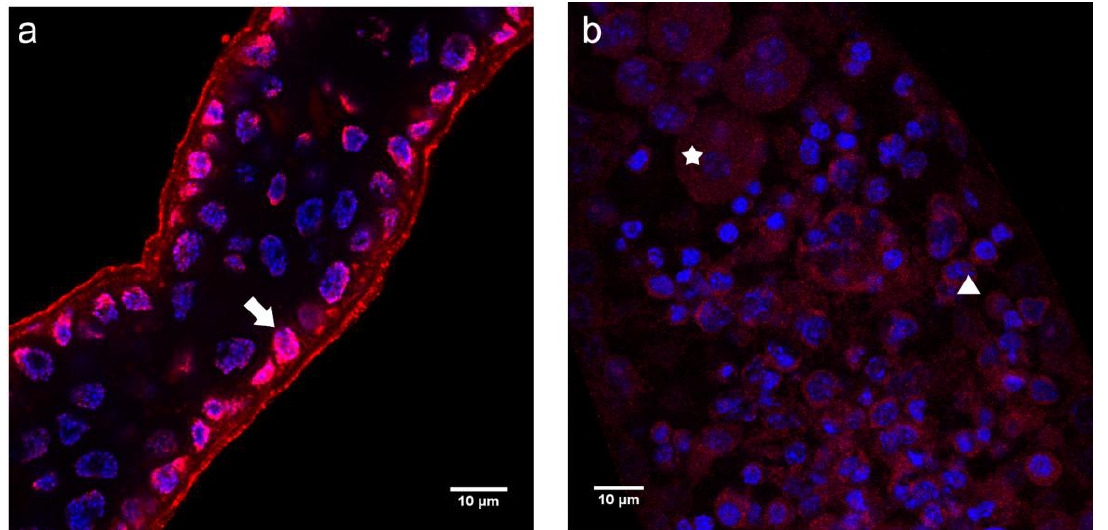
Figure 2. Immunofluorescence analysis with an antibody raised against the